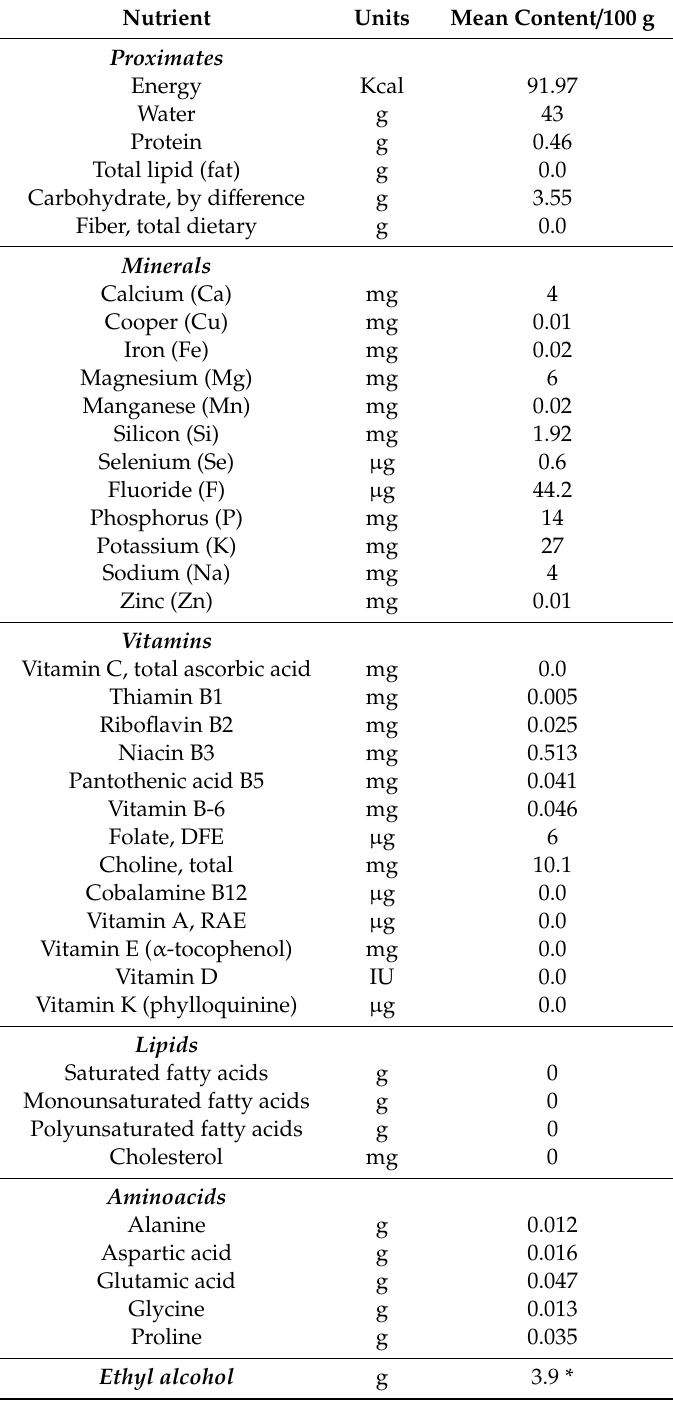
Table 2. Mean nutrient composition of regular